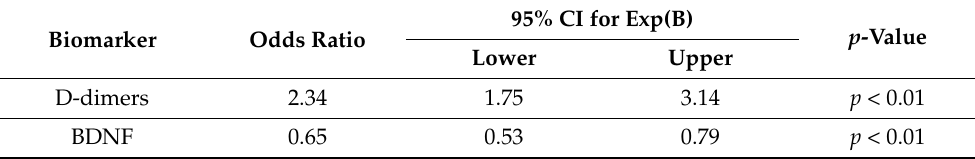
Table 5. Binary logistic regression of BDNF and D-dimers for diagnostic of PE.